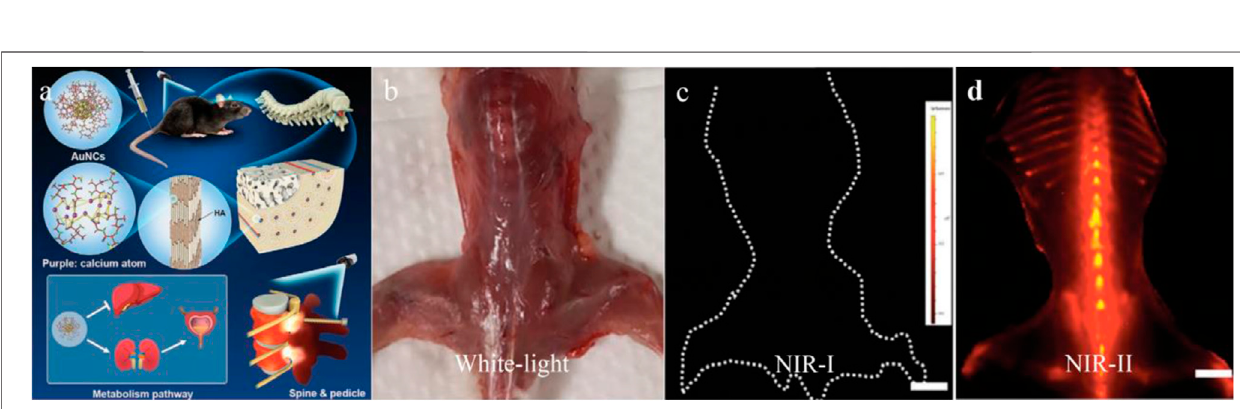
FIGURE 4 | Gold nanoclusters for NIR-II fl uorescence imaging of bones. (A) The structure of AuNCs and the schematic for bone targeting. (B – D) Compared with the clinically available ICG, the AuNCs showed obvious fl uorescence in spinal, vertebral vertebrae, distal femur, and proximal tibia. Scale bar: 10 mm. Reproduced with permission from Li et al.